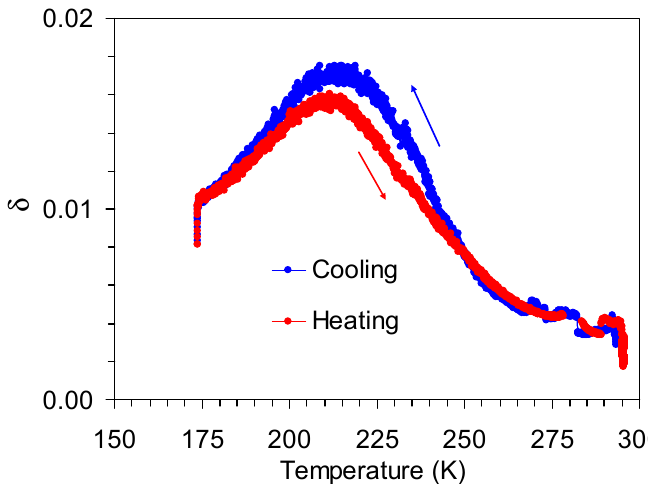
Figure 4. Continuous temperature spectra of the internal friction registered in a cooling–heating scan between 290 and 173 K for a Structure 1 sample with two a/c twin boundaries. Cooling–heating rate 1 K/min, oscillatory strain amplitude 2 × 10 − 7 .